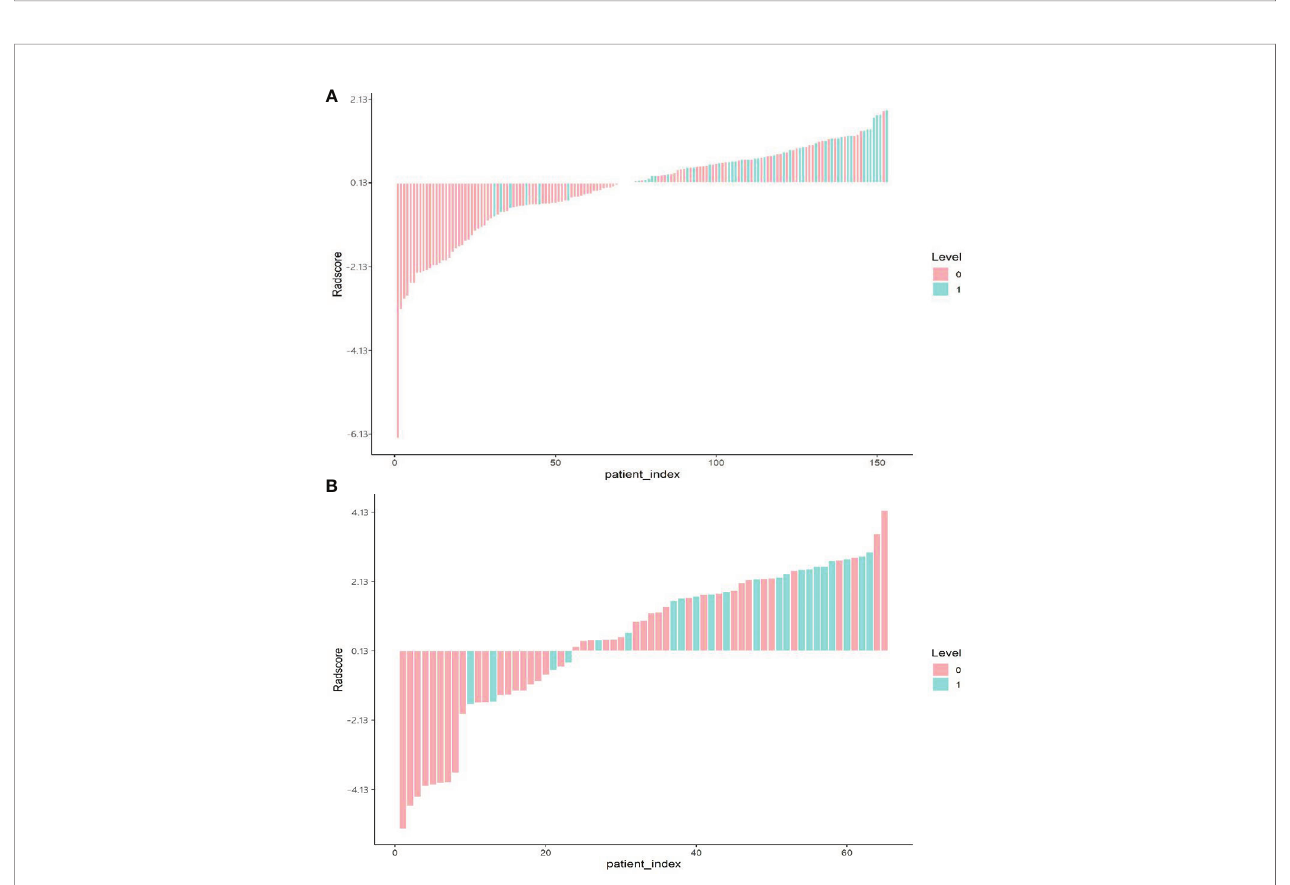
FIGURE 3 | Bar plot of the radiomics signature value for each patient in the training cohort (A) and the validation cohort (B). 0, good control (red); 1, local uncontrolled or recurrent